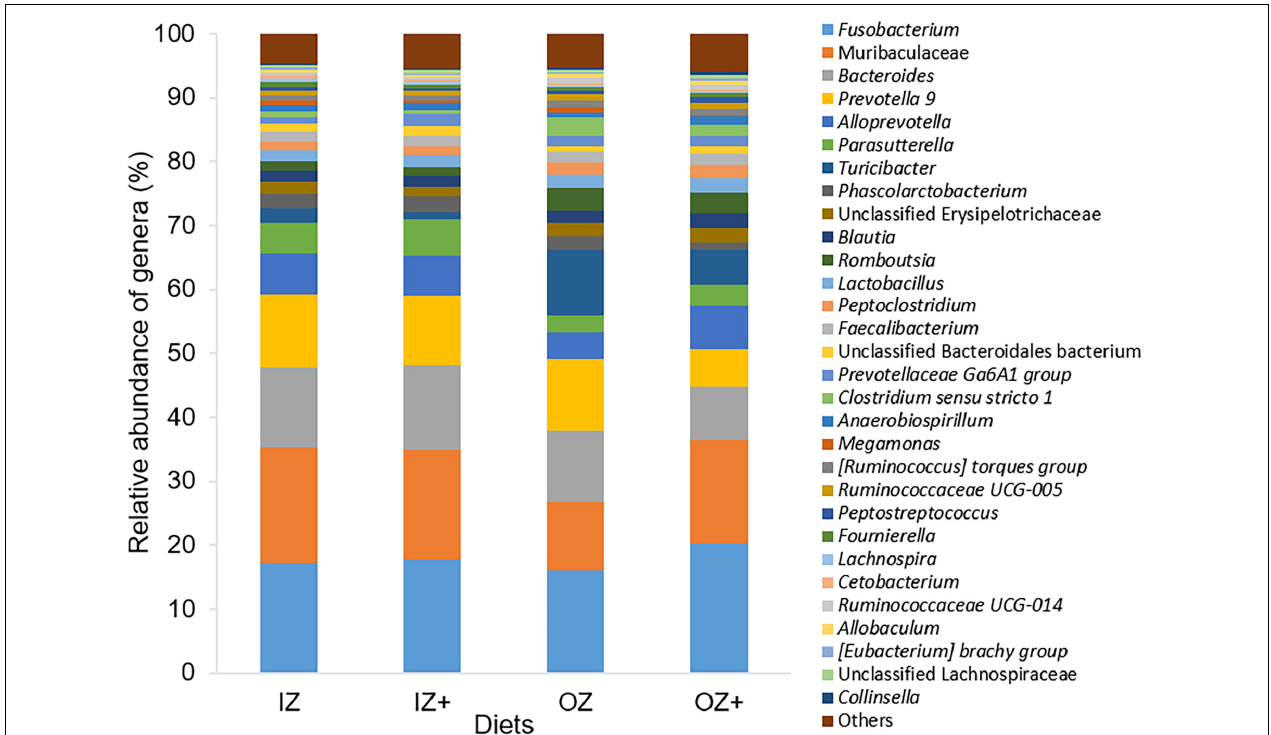
FIGURE 3 | Relative abundance (%) of bacterial genera in fecal samples of dogs fed diets supplemented with inorganic (IZ and IZ +) and organic (OZ and OZ +) Zn sources without (IZ and OZ) and with (IZ + and OZ +) the addition of a multi-enzymatic complex from the solid-state fermentation of Aspergillus niger . Genera with relative abundance < 0.5% were pooled and named “Others.”